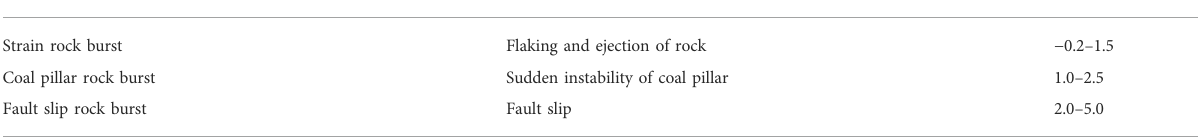
TABLE 1 Rock burst classi fi cation, source, and